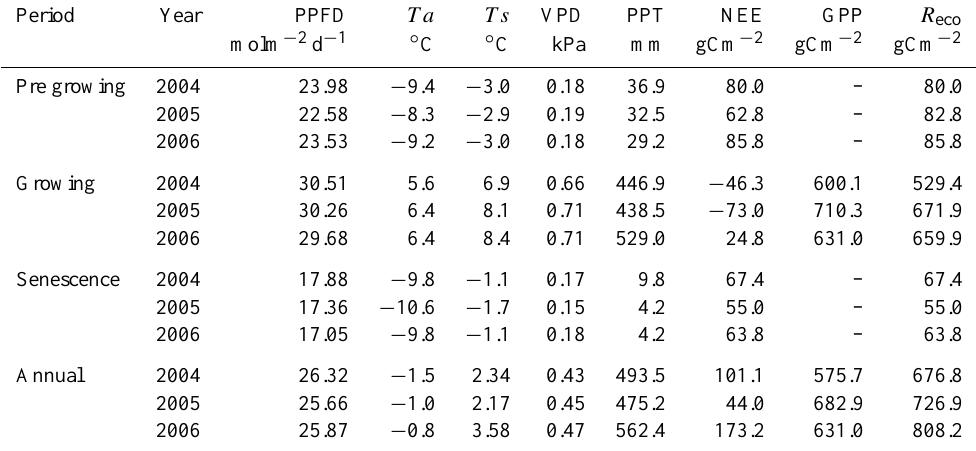
Table 1. Average daily values of photosynthetically active radiation (PPFD), air temperature ( Ta ), vapor pressure deficit (VPD), soil temper- ature ( Ts : 5cm depth), total precipitation (PPT), ecosystem respiration ( R eco ) , gross primary production (GPP), and net ecosystem carbon exchange(NEE) for various periods during each year: pre-growing period (1 January to 20 April), Growing season (21 April to 26